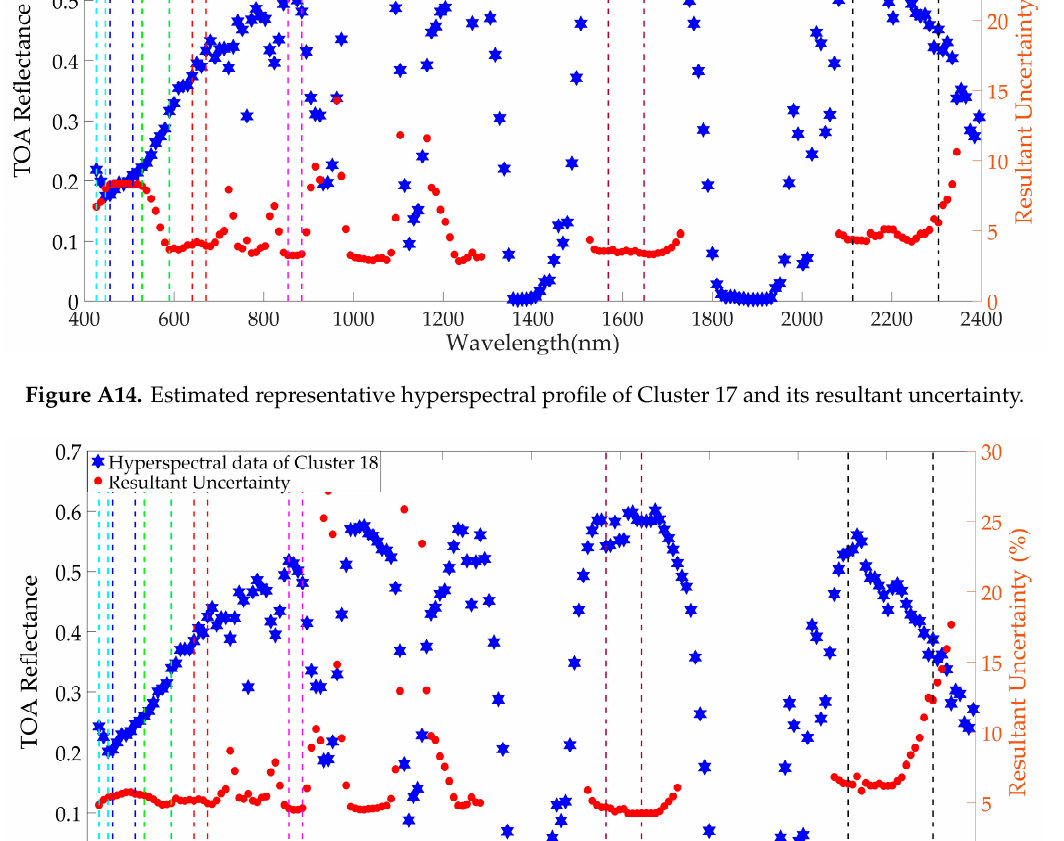
Figure A16. Estimated representative hyperspectral profile of Cluster 19 and its resultant uncertainty. References 1.